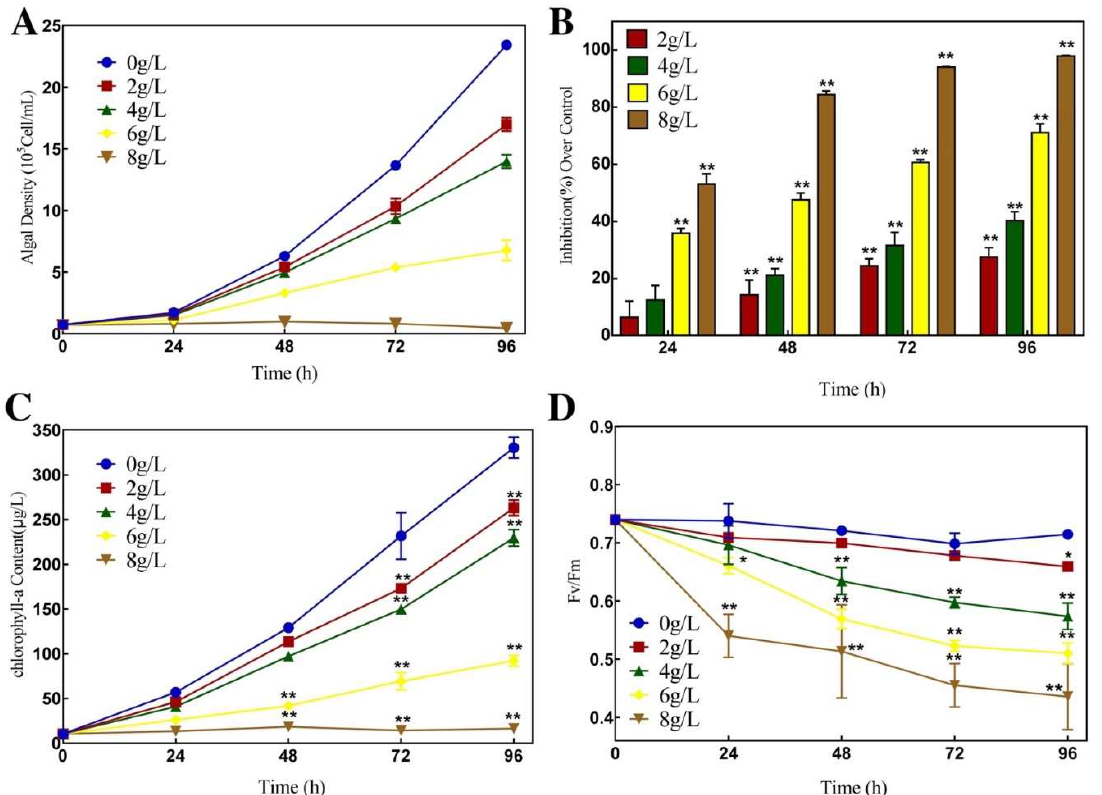
Figure 1. Effects of E. acoroides aqueous extract on ( A ) growth curve; ( B ) inhibition rate; ( C ) chlorophyll-a concentration; ( D ) photosynthetic efficiency (Fv/Fm). Data are means ± SD (n = 3). * p < 0.05, ** p < 0.01 indicate significant differences.